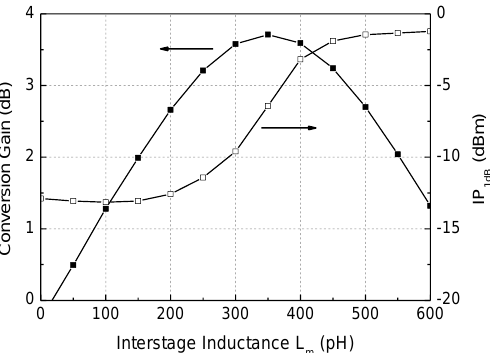
Figure 4. Effects of the interstage inductance L m on the mixer performance.